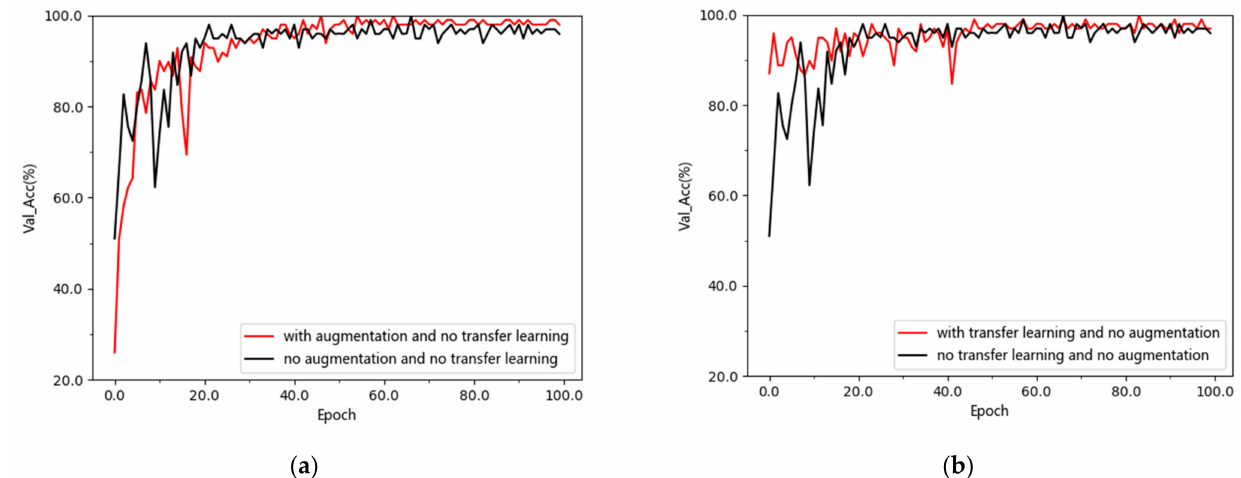
Figure 7. Effects of data augmentation and transfer learning on model convergence performance and recognition accuracy: ( a ) The effect of data augmentation technology on network convergence and classification accuracy without transfer learning; ( b ) The effect of transfer learning on network convergence and classification accuracy with no data augmentation